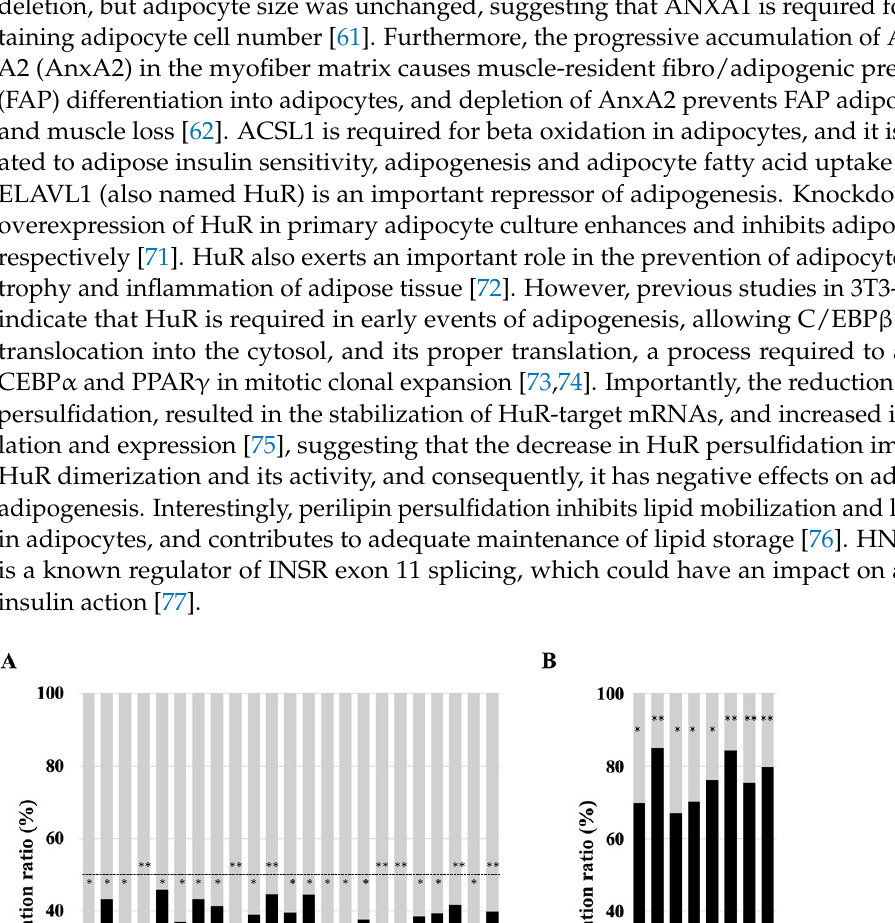
activated protein kinase kinase kinase kinase 4; PREB, Prolactin regulatory element-binding protein; RELA, Transcription factor p65; SLC39A14, Metal cation symporter ZIP14; STAT1, Signal transducer and activator of transcription 1-alpha/beta; STAT3, Signal transducer and activator of transcription 3. Student t -test significance: * p < 0.05; ** p <